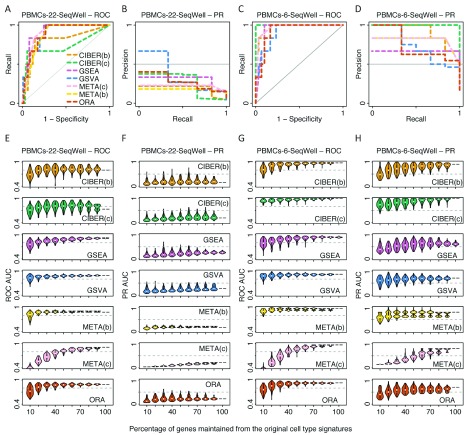
Performance and robustness analysis of cell type prediction methods using Seq-Well PBMCs scRNA-seq data.The same procedure as described in
Figure 2 for ROC and PR AUCs of the liver and retinal neuron datasets was used here for the PBMC dataset measured with the Seq-Well technology. Please see
Figure 2 legend for details. Six cell clusters from the Seq-Well scRNA-seq measurements could be mapped vs. six out of 22 cell types of the PBMC LM22 matrix signatures. This dataset was analysed in two ways. In the first way (‘PBMCs-22-SeqWell’, panels
A,
B,
E and
F), all 22 cell type signatures from the LM22 matrix were used as input for cell type prediction methods. In the second way (‘PBMCs-6-SeqWell’, panels
C,
D,
G and
H), only the six cell types from the LM22 that could be mapped to the six cell clusters were used as input for cell type prediction methods. For CIBERSORT and METANEIGHBOR, two approaches were used, one with the original LM22 matrix with continuous gene expression values, that we called CIBERSORT ‘continuous’ (CIBER(c)) and METANEIGHBOR ‘continuous’ (META(c)), and another with a thresholded and binarized version of the LM22 matrix, that we called CIBERSORT ‘binary’ (CIBER(b)) and METANEIGHBOR ‘binary’ (META(b)).